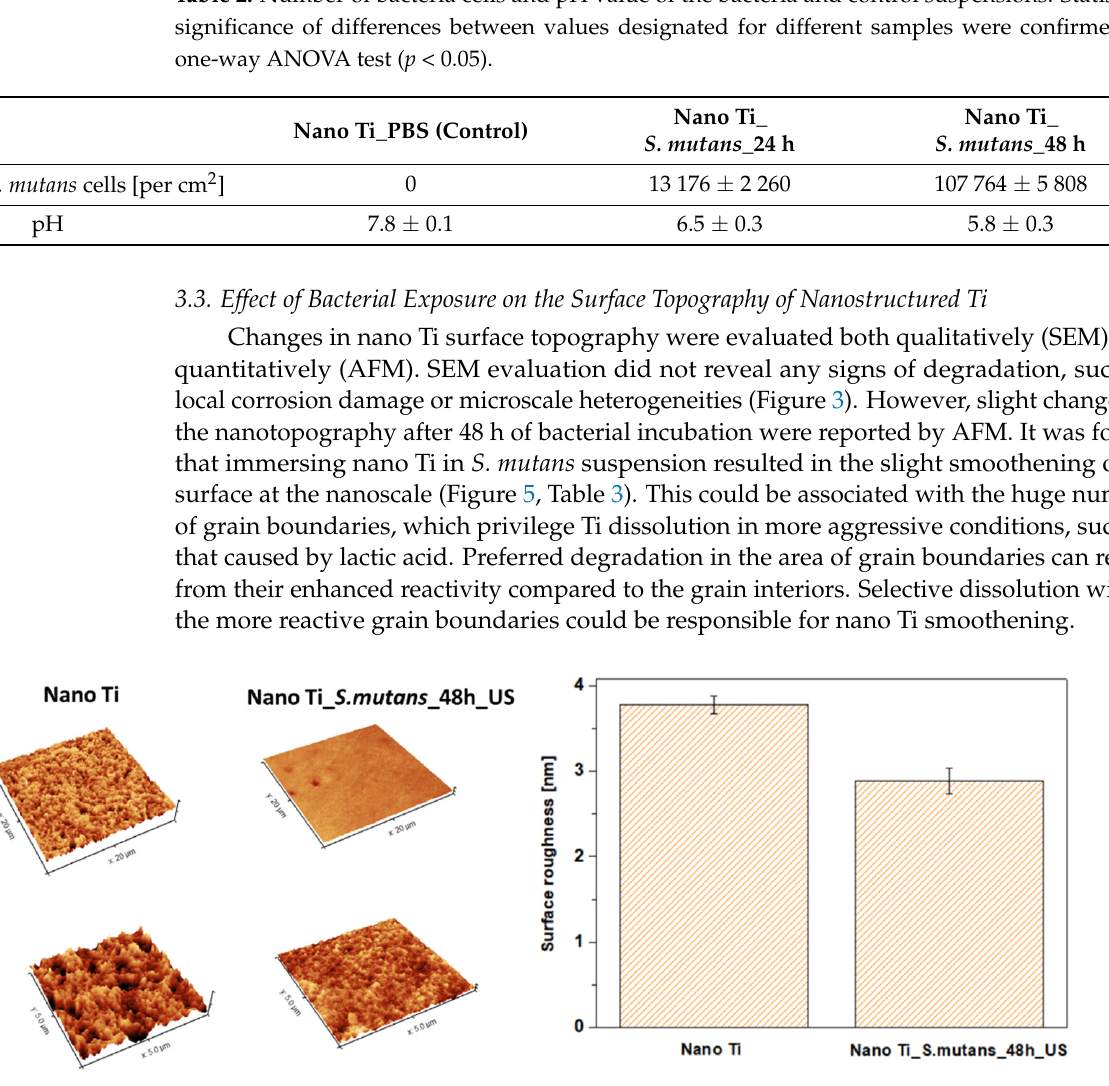
Figure 5. Surface roughness of nanostructured Ti in the polished state and after bacteria removal (AFM studies). Table 3. Values of arithmetic roughness (Ra) designated for the nano Ti in a polished state and after 48 h of incubation in S. mutans and subsequent bacteria removal. Statistical significance of difference between values designated for different samples was confirmed by one-way ANOVA test ( p <